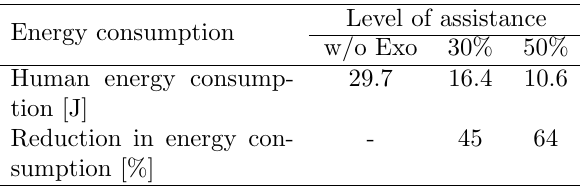
Level of assistance